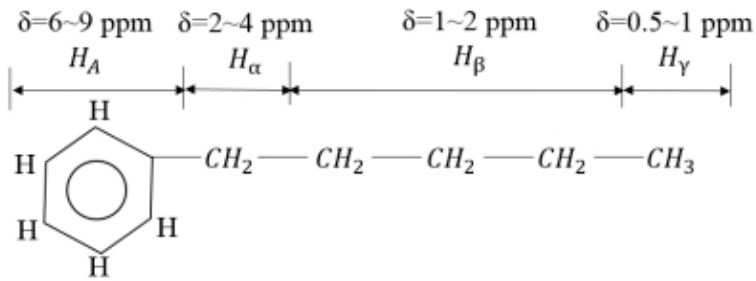
Figure 1. Assignments for 1 H chemical shifts.